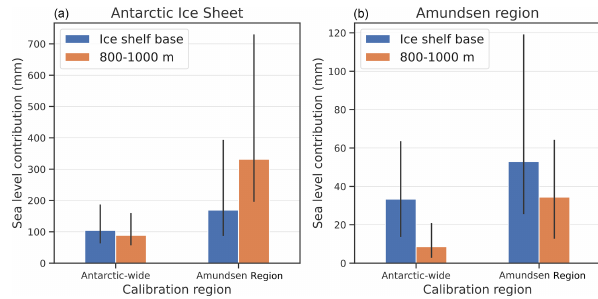
Figure 10. Projections of Antarctic sea level contribution for SSP5- 8.5 for all calibrated ESM-RF combinations for the AIS (a) and Amundsen Region (b) . Results are shown for thermal forcing near the ice shelf base. The bars show the median projections for the Antarctic-wide and Amundsen Region calibration using the linear (blue) and quadratic (orange) parameterisations. The spread indi- cates the 17th–83rd percentiles.